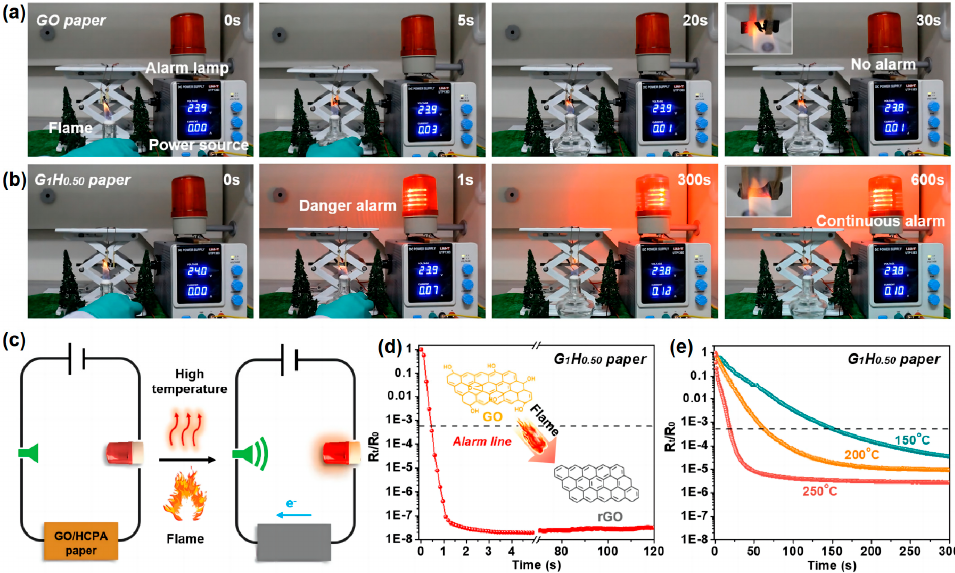
Figure 17. Images of ( a ) GO and ( b ) G 1 H 0.50 paper’s flame detection methods. ( c ) A schematic representation of the fire alarm sensor based on GO/HCPA paper operating in a high-temperature or flame attack scenario. Electrical resistance transition behavior of the G 1 H 0.50 paper under ( d ) flame attacks and ( e ) different ambient temperatures [72].